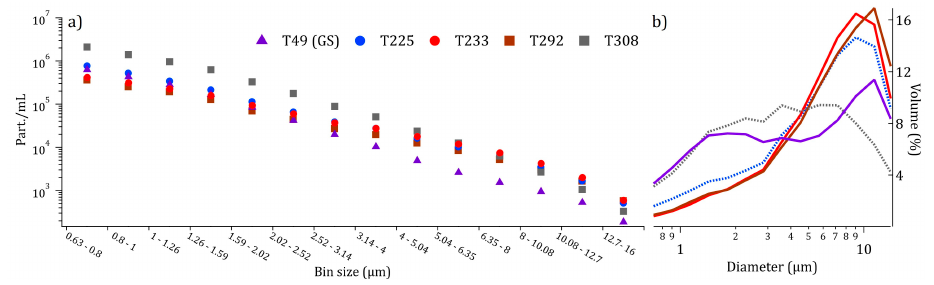
Figure 4. ( a ) number and ( b ) relative volumetric size distribution of microparticles measured by Coulter counter (14 bins) in 1 m ice sections prior to filtering.